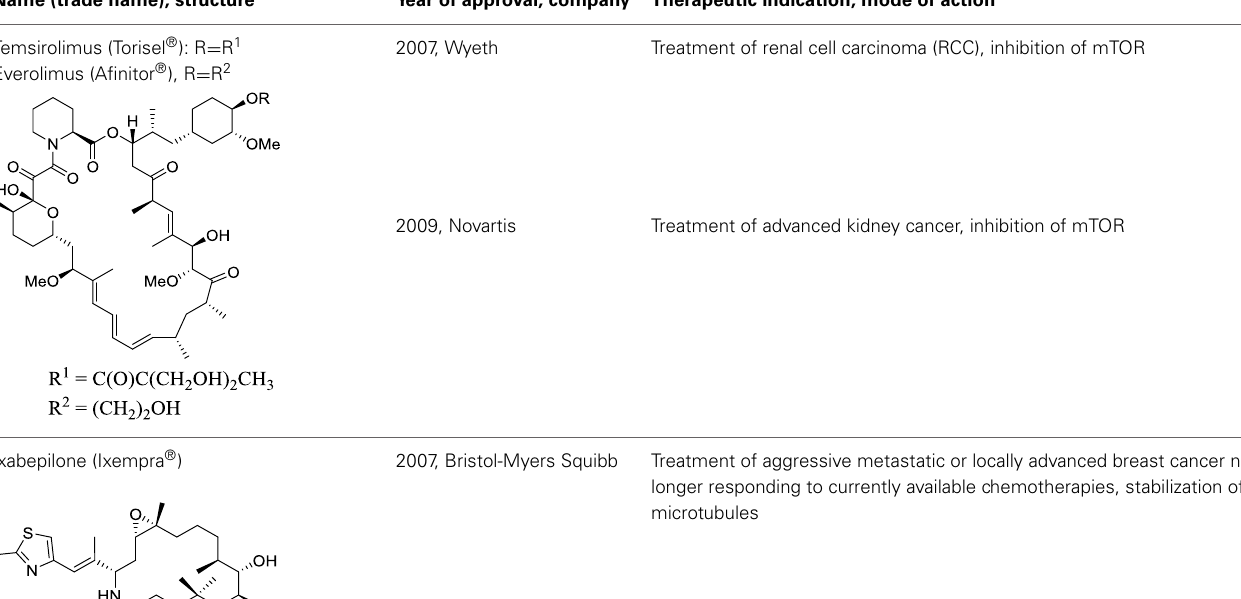
Table 1 | Novel anticancer medicines based on natural products. Name (trade name),